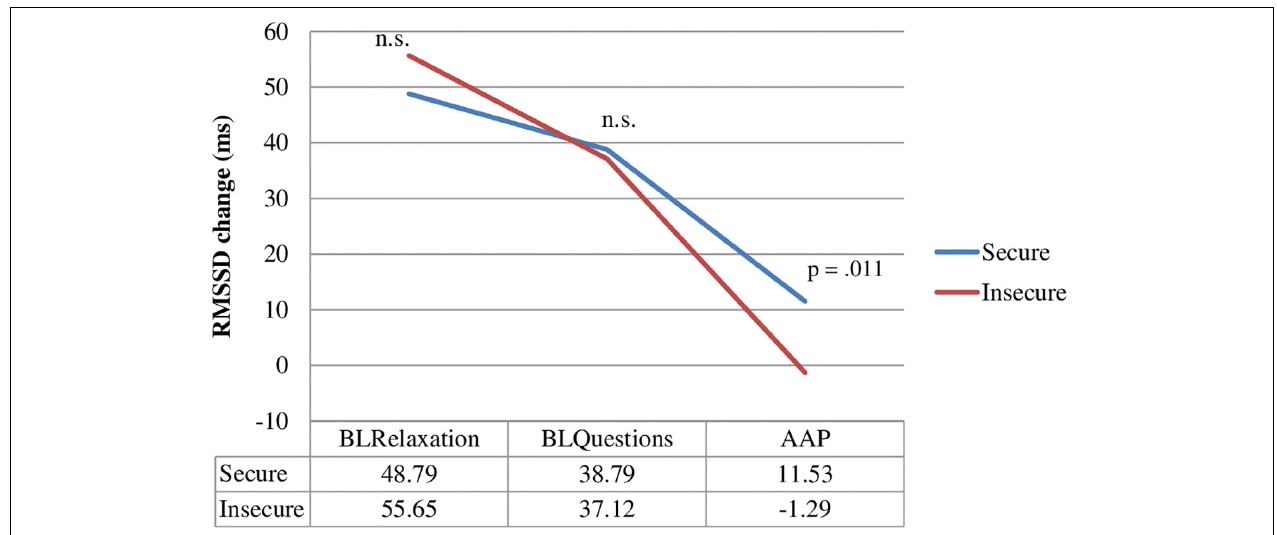
FIGURE 4 | RMSSD measurement of adolescents classified as secure and insecure for the baseline relaxation (BLR), the baseline questions (BLQ), and the attachment interview (AAP).